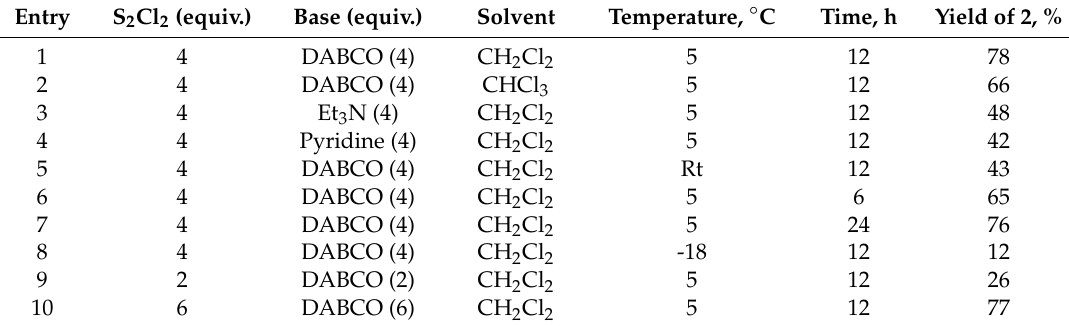
Table 1. Reaction of pyrimidin-2-amine (1 equiv.) with disulfur dichloride.